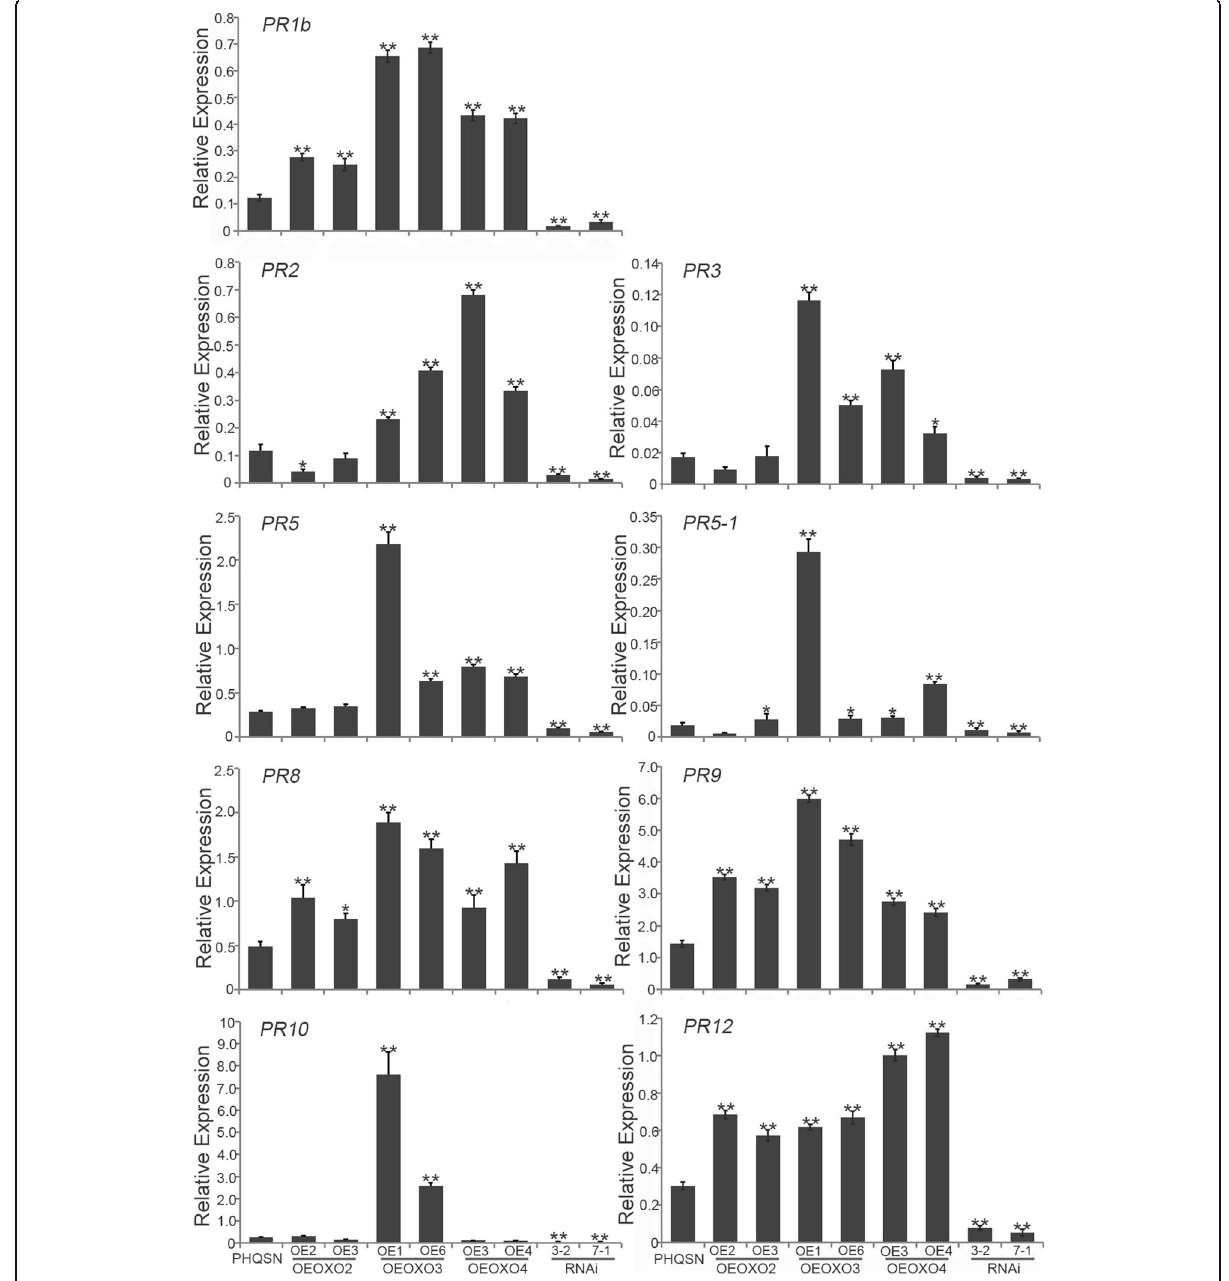
Fig. 4 Expression analysis of pathogenesis-related ( PR ) genes in the OXO transgenic plants and control plants by quantitative RT-PCR. Error bars indicate the SD from three biological replicates and asterisks indicate statistically significant differences compared to the control plants ( t test, ** P < 0.01; * P <